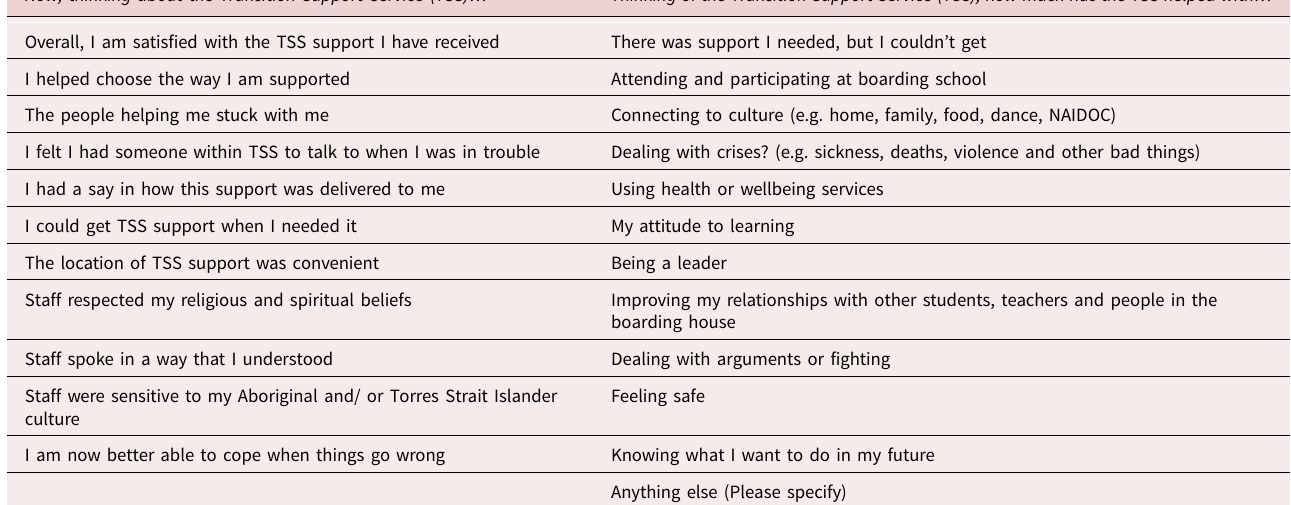
Table 1. Questions asked about